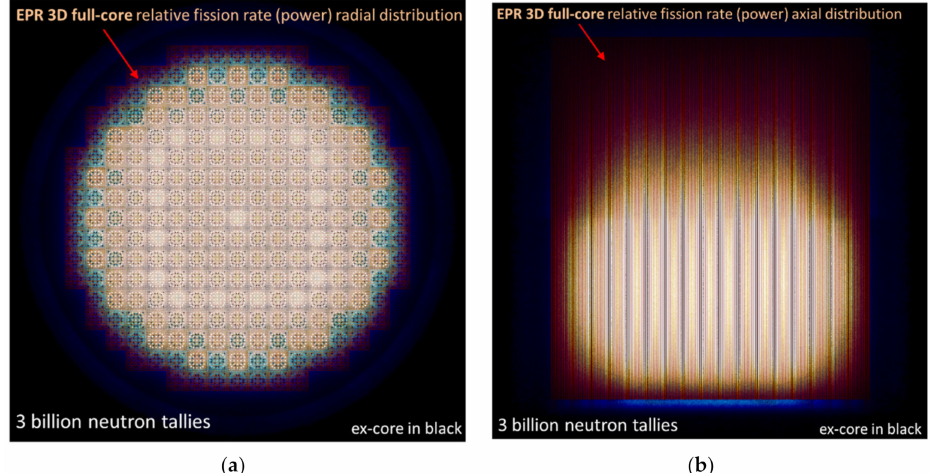
Figure 13. Simulated normalised fission rate (power) distributions in the EPR full core (BOC, hot full power (HFP)) using Serpent: ( a ) radial view at the core’s mid-plane; ( b ) axial view. (Dark and bright colors indicate low and high values, respectively. The core structure and elements are specified in Figures 2 and 3).